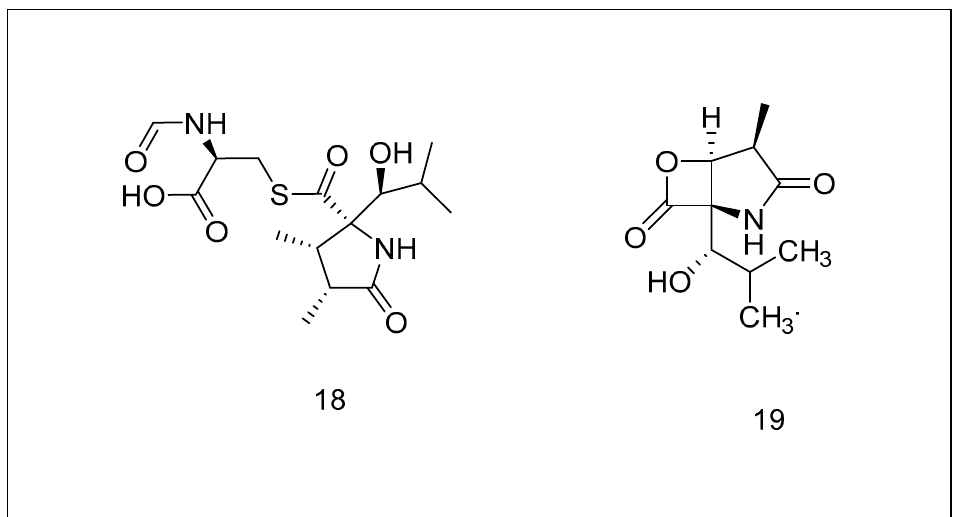
Figure 7. Chemical structures of ( 18 ) lactacystin and ( 19 ) clasto-lactacystin b-lactone.